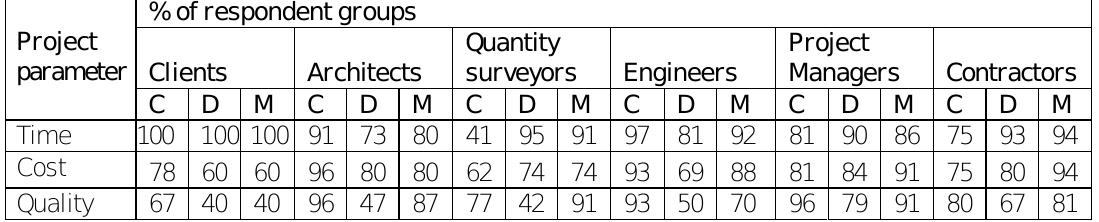
Table 8: Perceptions about whether clients are satisfied with the time, cost and quality management of their building projects using the listed procurement systems (C = Conventional; D = Design and Build; M = Management oriented) % of respondent